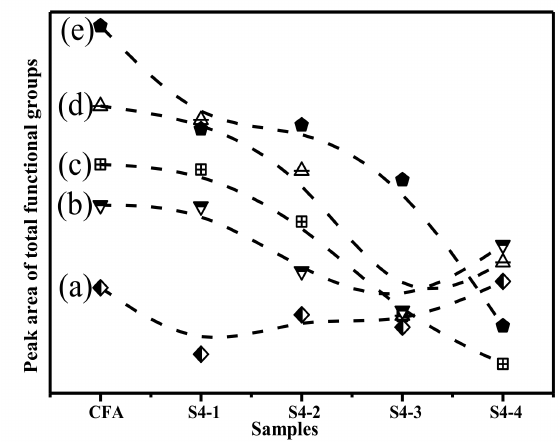
Figure 5. The area under each Gaussian function of samples: ( a ) Asymmetric stretching of (Si,Al)- O-Si in mullite or mullite-like structures. ( b ) Asymmetric stretching of (Si,Al)-O-Si in Q 3 units; ( c ) Symmetric stretching of Si-O-Si in Q 2 units; ( d ) Symmetric stretching of Si-O-Si in Q 3 units; ( e ) Asymmetric stretching of (Si,Al)-O-Si in amorphous